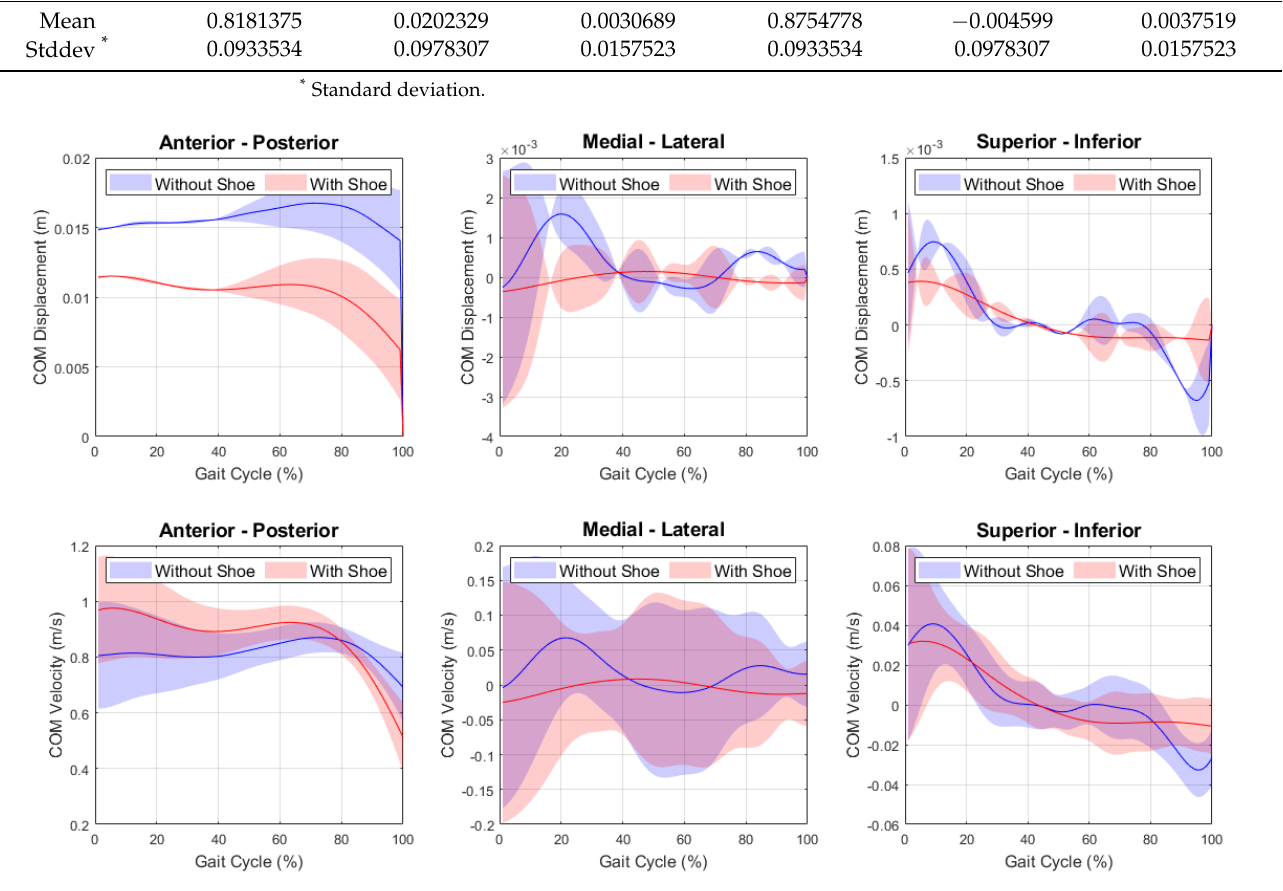
Figure 9. COM variables (displacement and velocity) of flatfoot subjects with and without shoes. Red line indicates mean ankle joint angle with shoe group and Blue line indicated mean ankle joint angle without shoe